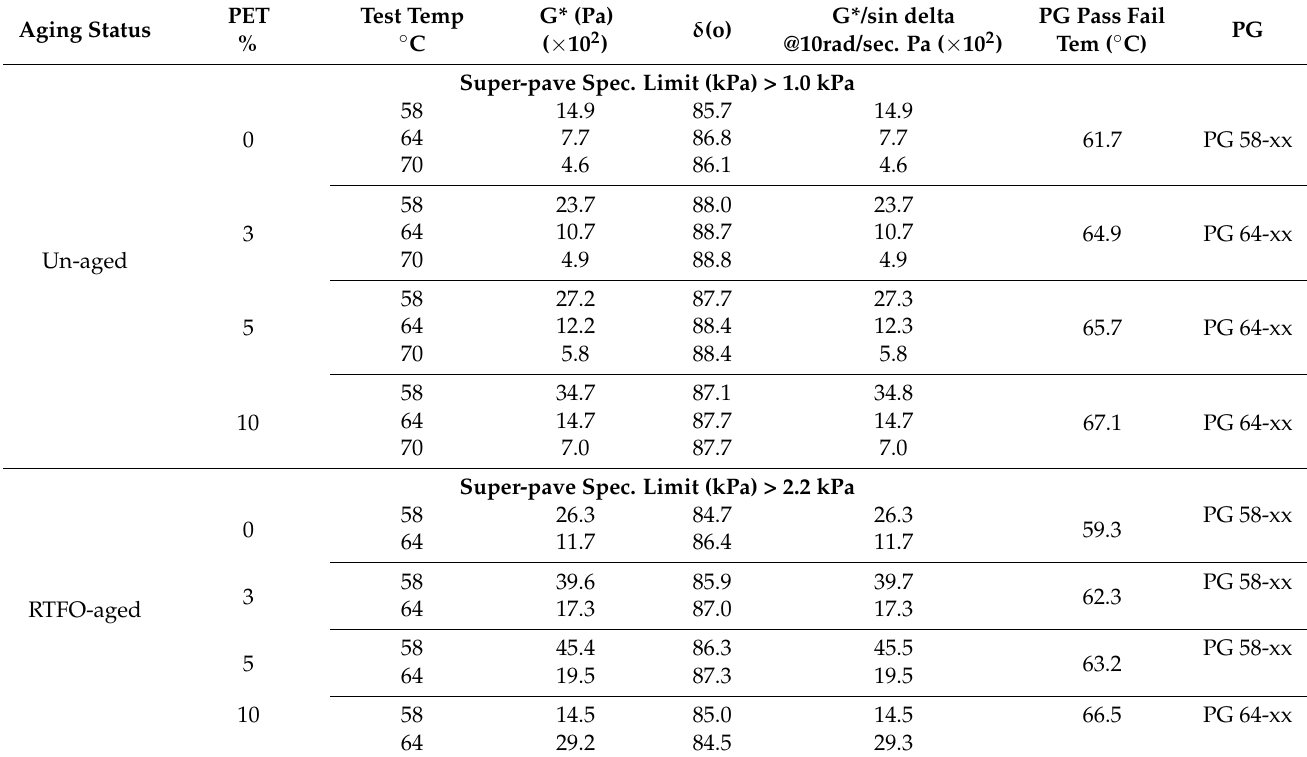
Table 5. Performance Grade determination for baseline and PET modified